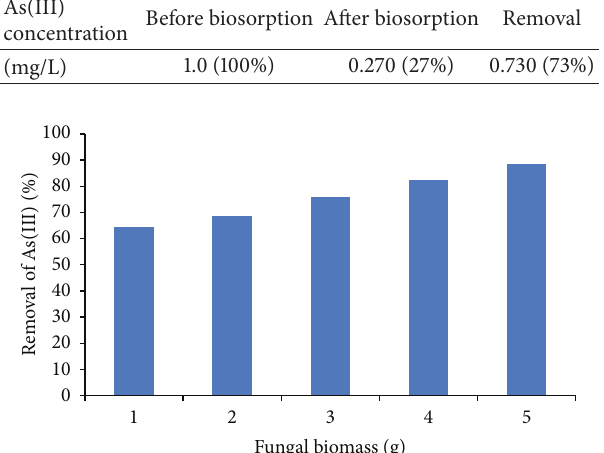
Table 1: Removal of As(III) of natural water contaminated with 1.0mg/L of As(III), 5g of iron-coated biomass, 100 rpm, 30 ∘ C, pH 6.5 (adjusted), 24 h of incubation.